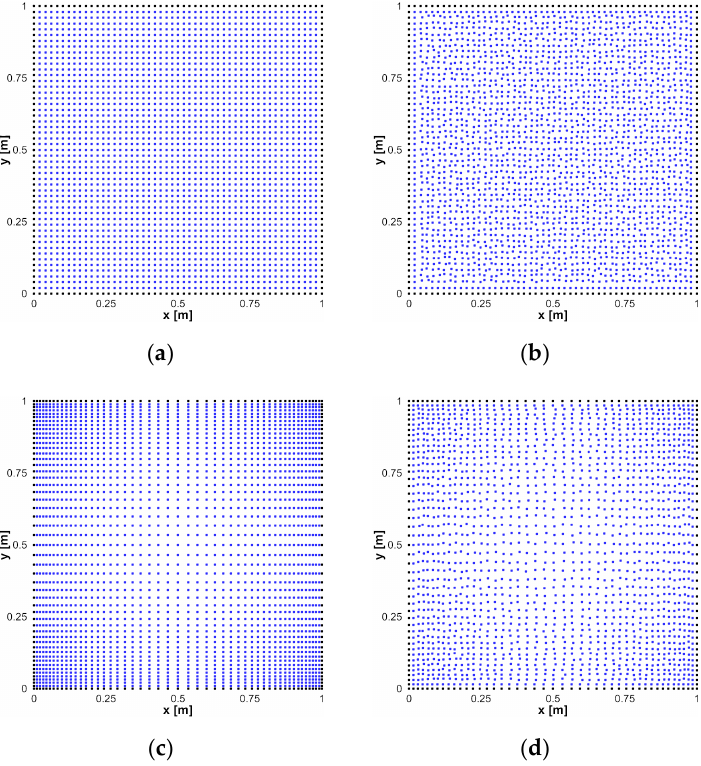
Figure 3. Distributions of calculation points: ( a ) uniform, ( b ) uniform with randomization, ( c ) variable, and ( d ) variable with randomization ( Re = 100; 51 × 51 points).